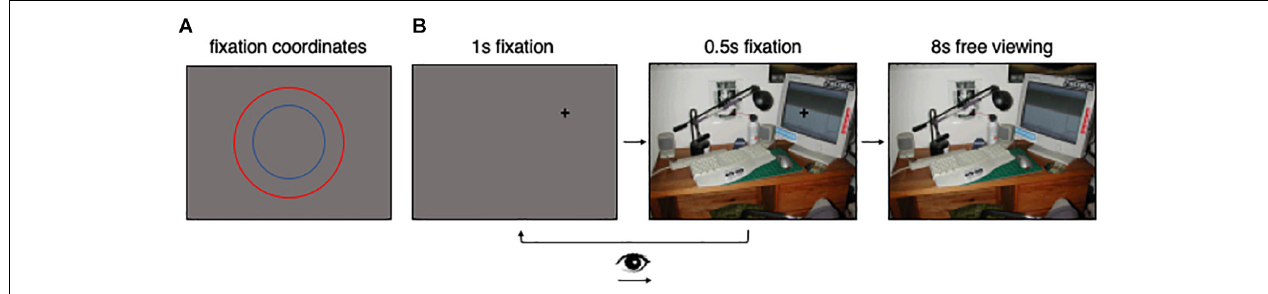
FIGURE 2 | Task figure. (A) Shows the locations of the concentric circles that the pretrial fixation coordinates were randomly selected from in this study. (B) Is a visual representation of the task.